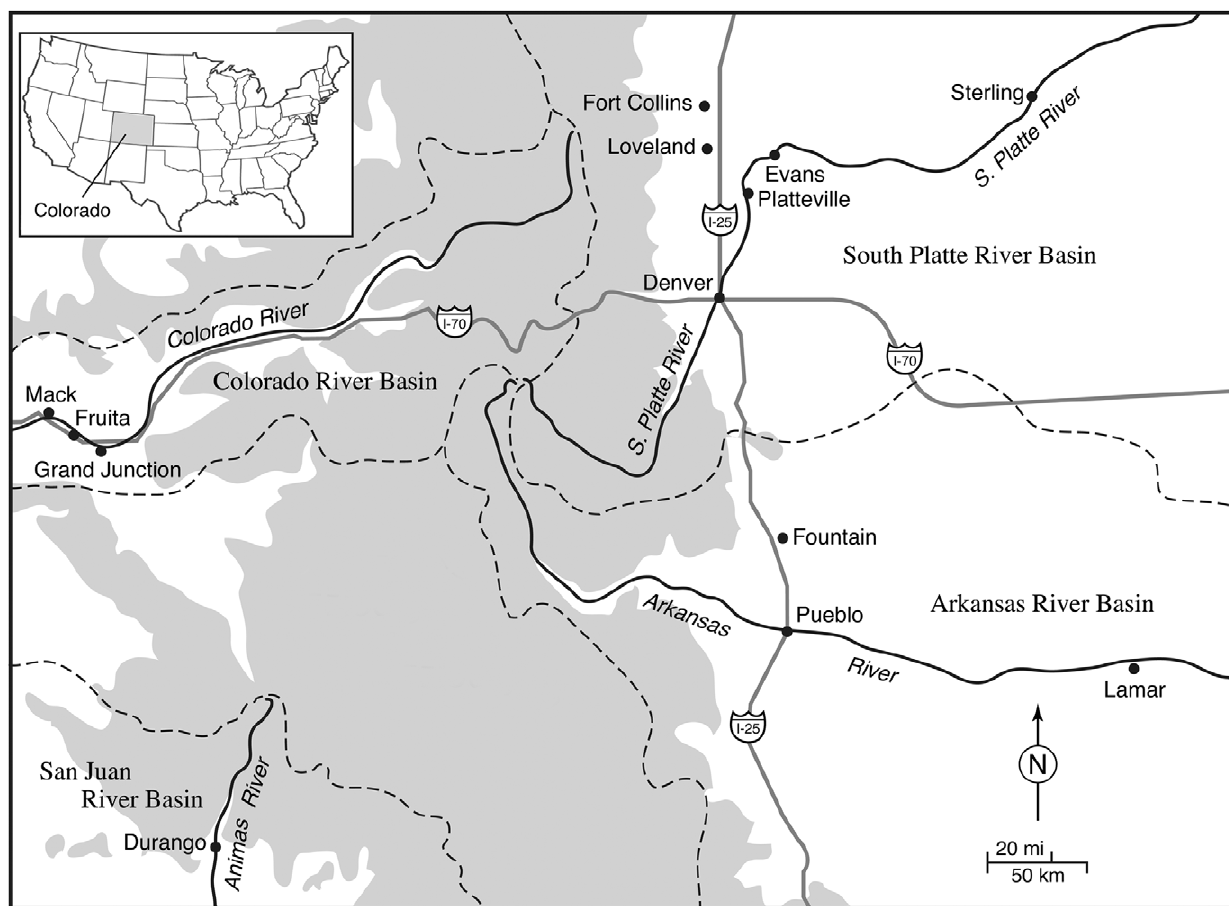
Figure 1. Map of study area. Sample sites (n=13) are shown, as well as the location of the Rocky Mountains (grey shading), major highways, and relevant waterways. Dashed lines indicate boundaries of the river basins in the state that were sampled in this study.